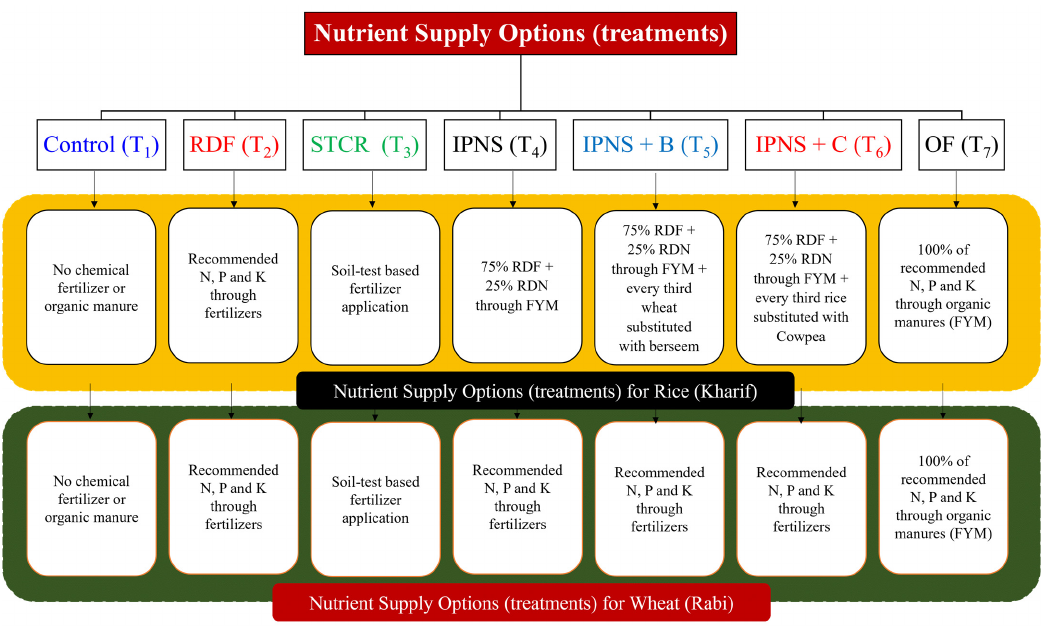
Figure 1. Experimental setup and treatment details for different nutrient supply options for rice – wheat cropping system.